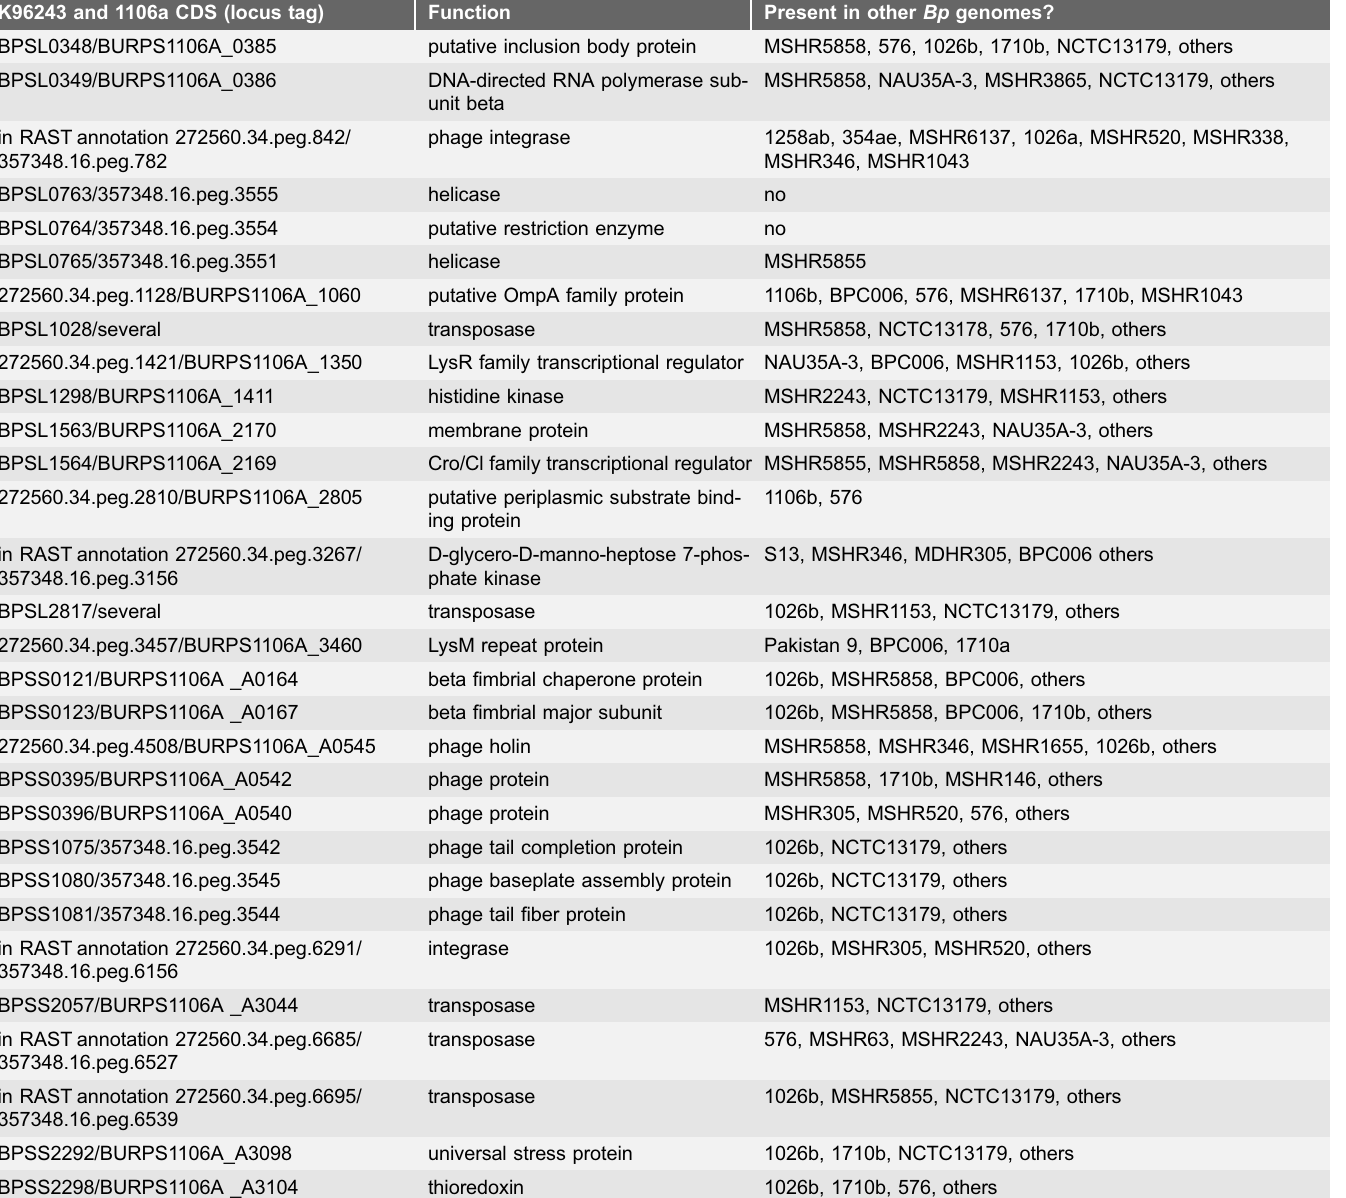
Table 4. Genes present in both K96243 and 1106a genomes that were absent in MSHR668. K96243 and 1106a CDS (locus